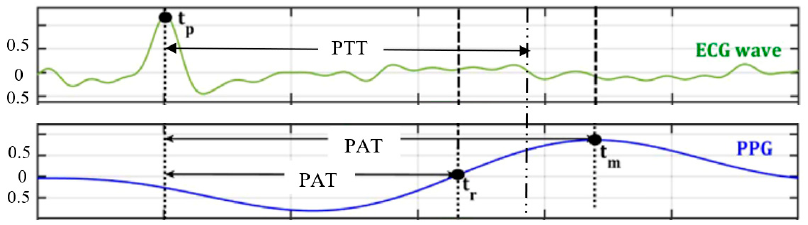
Figure 5. Synchronized ECG and PPG, and the PTT between the two signals. Note. Adapted from [43] Figure 6. Synchronized ECG and PPG, and the PTT between the two signals. (Adapted from Figure Figure 2 “Blood Pressure Estimation Using On-body Continuous Wave Radar and Photoplethysmo- 2 [43]) . gram in Various Posture and Exercise Conditions”, by Pour Ebrahim, M., Heydari, F., Wu, T. et al., 2019, Sci Rep 9, 16346 (2019). (https://doi.org/10.1038/s41598-019-52710-8, accessed on 30 December 2021). CC BY